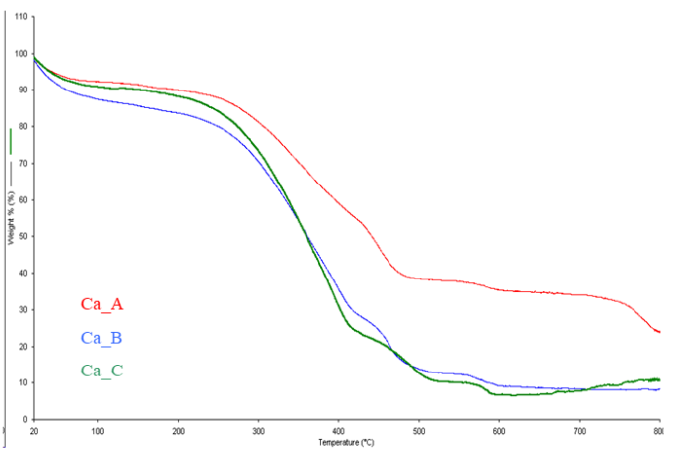
Figure 13. Thermogravimetric curve for the Ca 2+ /Dop − precipitates obtained at different metal:ligand molar ratios and I = 0.15 mol dm − 3 . Component concentration in the solution: c Ca2+ = 1.5 mmol dm − 3 and c Dop − = 1.5–7.5 mmol dm − 3 . Atmosphere of air (gaseous mixture of nitrogen and oxygen with 80% and 20%, v / v , respectively) at a flow rate of 100 mL min − 1 and a scanning rate of 10 K min − 1